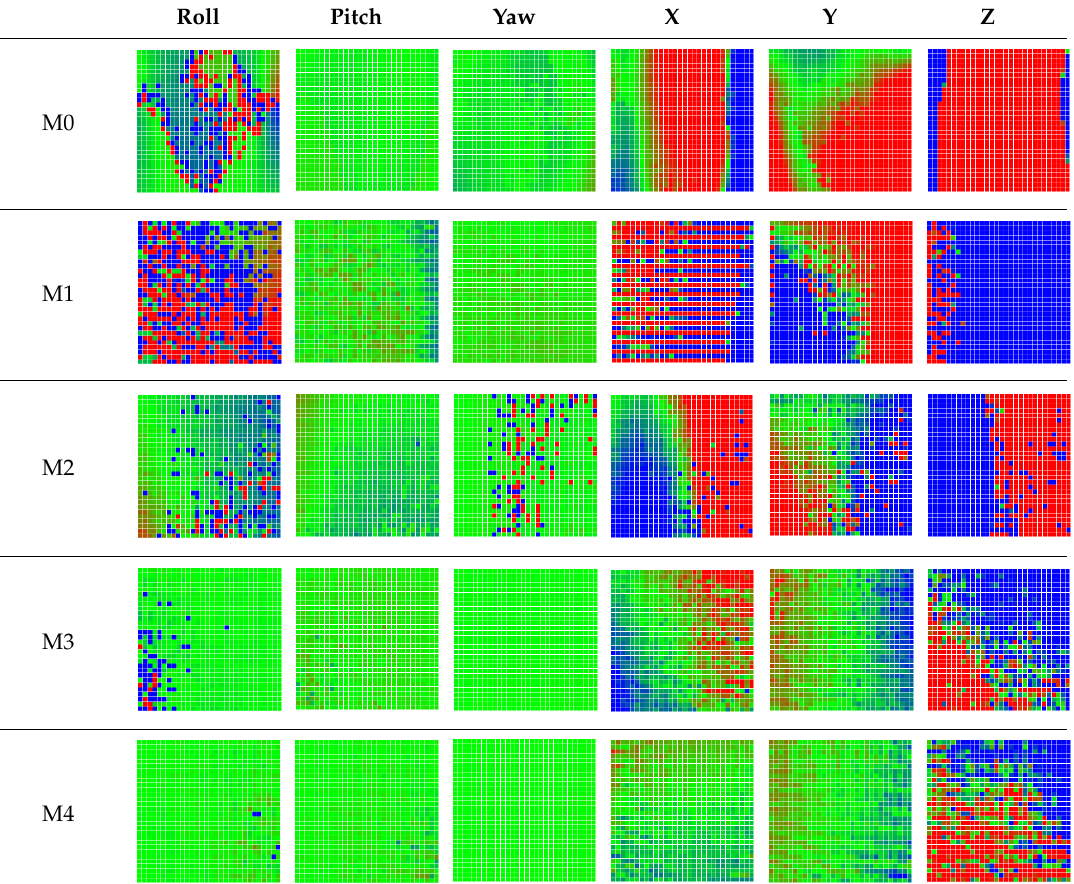
Table 7. Performance comparison between the Aruco grid boards described in this paper. The normal to the tag is parallel with the camera Z-axis.